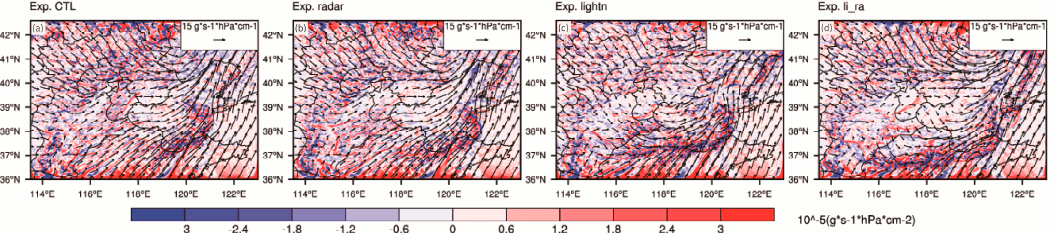
Figure 9. Water vapor flux (g·s − 1 ·hPa·cm − 1 ) andwater vapor flux divergence (g·s − 1 ·hPa·cm − 2 ) in: ( a ) Exp. CTL; ( b ) Exp. Radar; ( c ) Exp. Lightn; and ( d ) Exp. li_ra at 850 hPa, 1030 UTC. The vector represents water vapor flux and the contour represents divergence of water vapor flux.